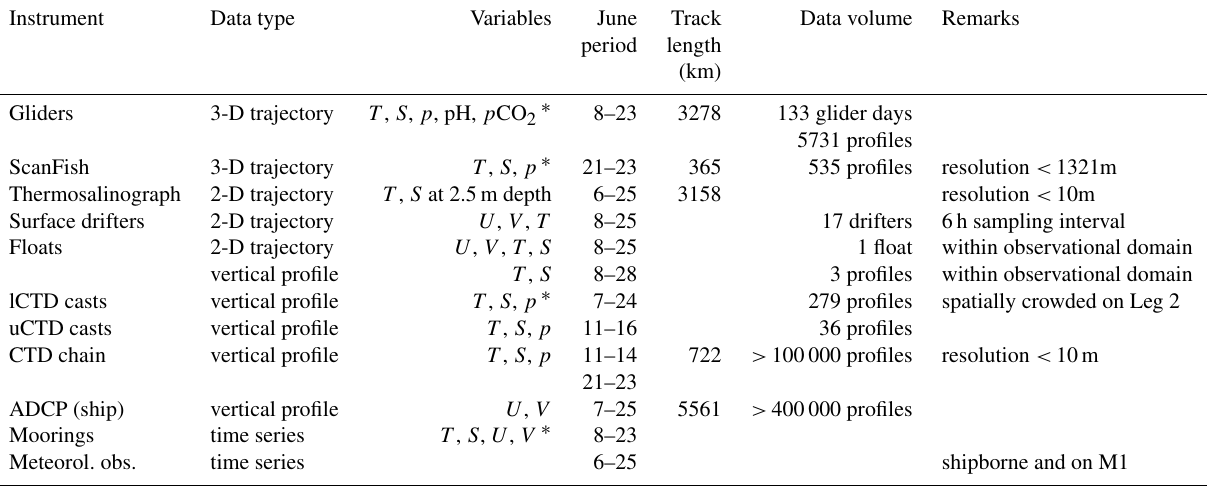
Table 2. Summary of all observations. The variables names p , p CO 2 , pH, T , S , U , and V refer to pressure, CO 2 partial pressure, pH value, temperature, salinity, zonal and meridional velocity, respectively. Only those variables are mentioned which are relevant for the articles in the special